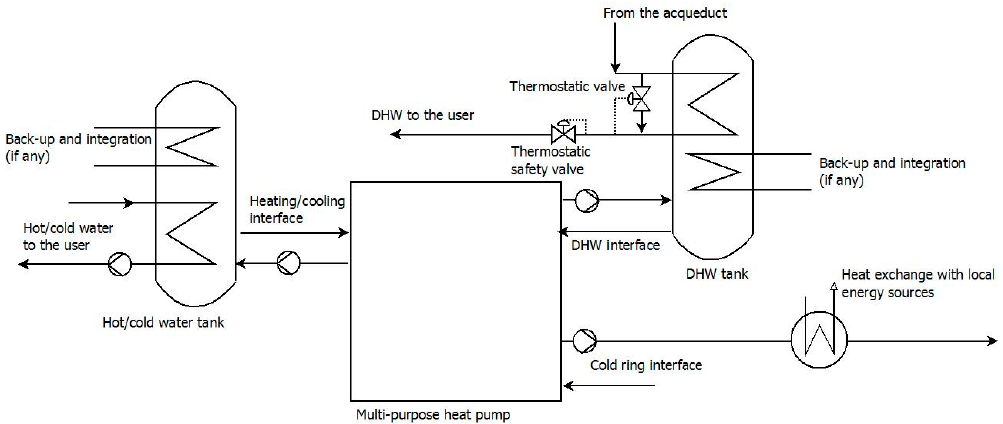
Figure 3. P&ID of an example of a substation for a cold district heating (CDH) network. DHW: domestic hot water.